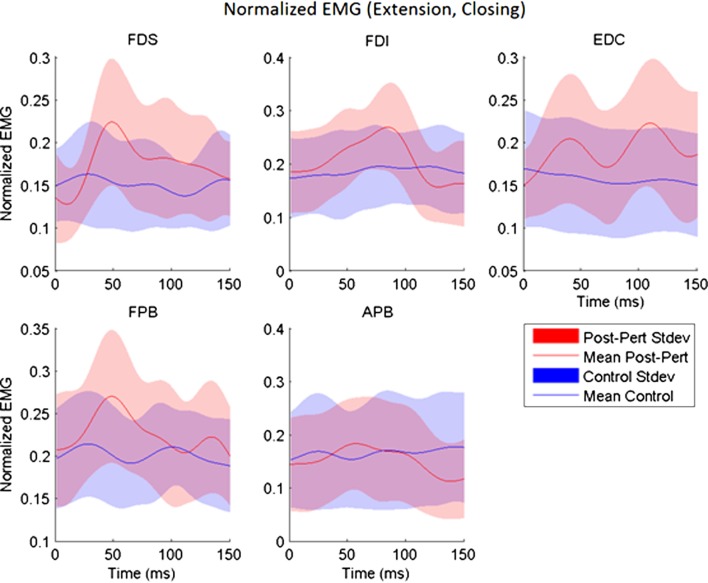
Across-subjects mean EMG envelopes for each muscle following extension perturbation during the closing phase. Unperturbed (blue) and perturbed (red) conditions are shown with their across-subjects mean values (line) and associated SDs (shaded).